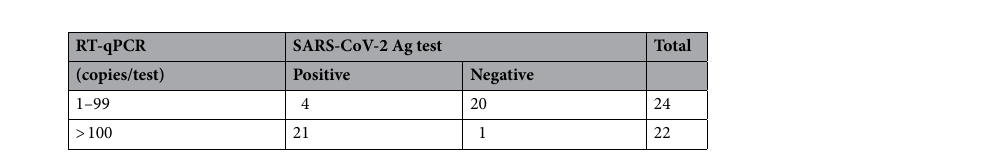
Table 6. Relationship between the SARS-CoV-2 viral loads and COI by the HISCL SARS-CoV-2 Antigen assay kit. SARS-CoV-2 severe acute respiratory syndrome coronavirus 2, RT-qPCR reverse transcription quantitative polymerase chain reaction, Ag